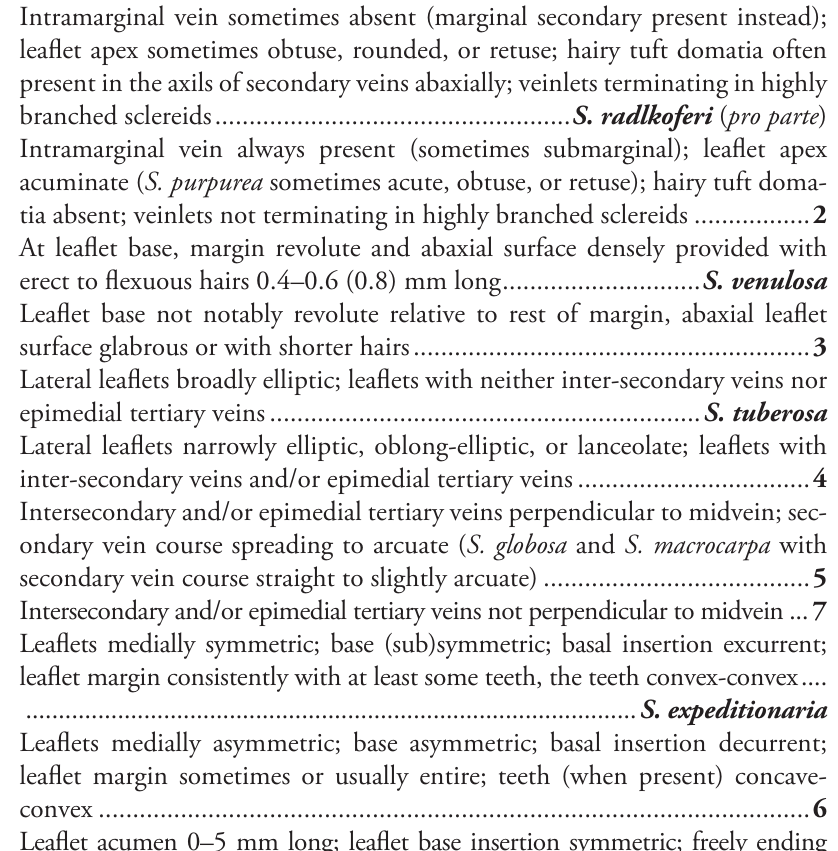
the filaments 1–1.7 mm long; fruits 1.8–2.8 (3.2) × 1.8–2.2 cm,